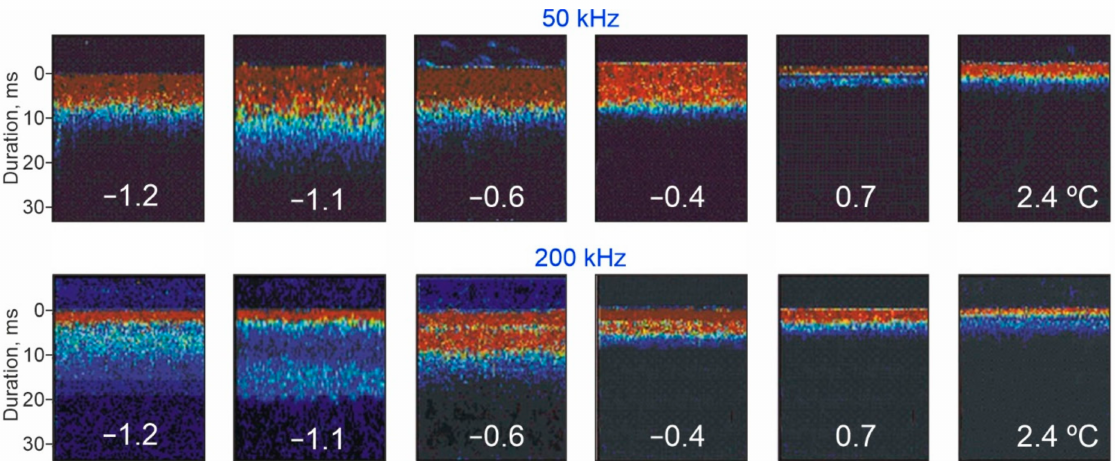
Figure 4. Fragments of echograms, 50 and 200 kHz. Echo duration ( y axis) at different sediment temperatures at 1 m sediment depth (white numerals).